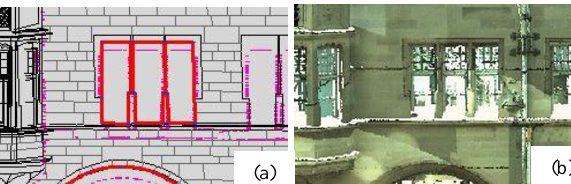
Figure 6. Impact of shadows on the reconstruction of the façade. (a) Reference vector model in red and extracted contour points in magenta before vectorization; (b) colorized TLS point